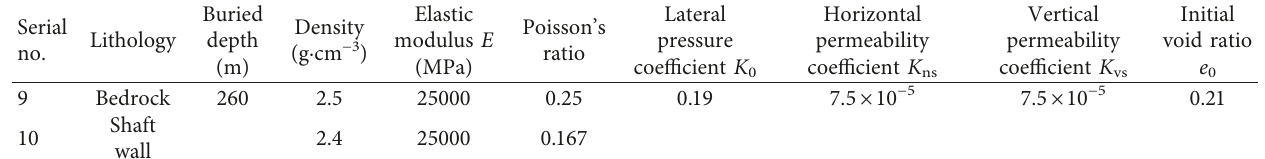
Table 2: Linear elastic model parameters of the well wall and weathering zone.